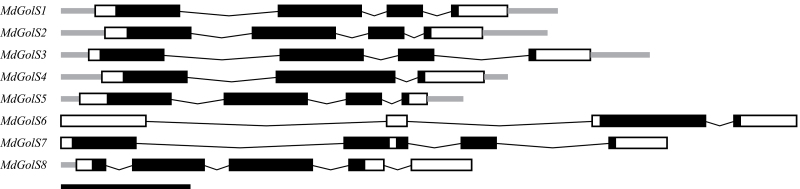
Gene structure of MdGolS genes. The GT8-coding domain is colored black and the remaining exon sequences are shown as white boxes. Gray boxes represent untranslated regions, while lines represent introns. Scale bar: 500 bp.